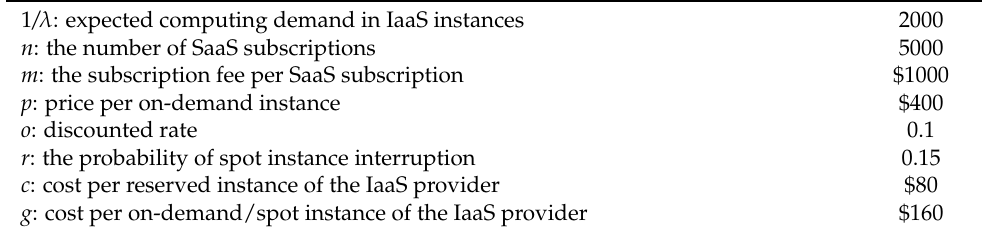
Table 2. Assumptions for the Illustration.